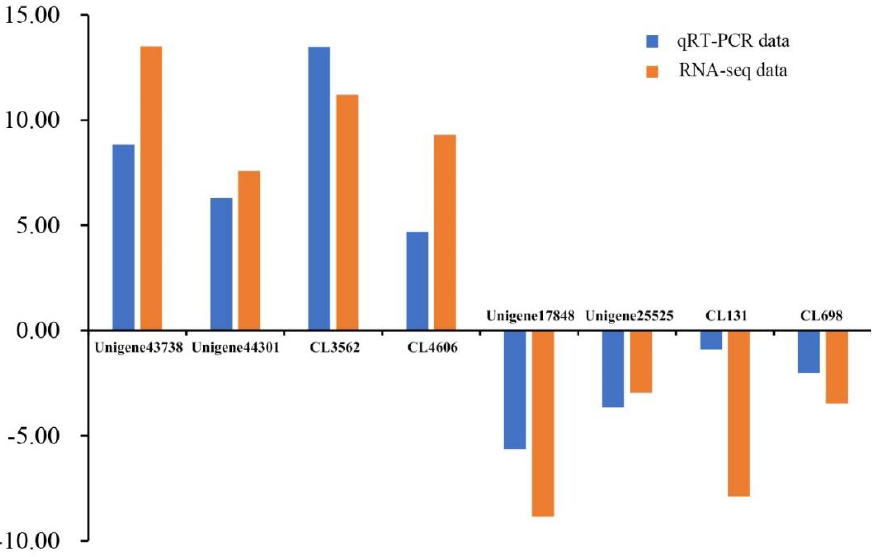
Figure 7. Expression levels of eight unigenes as determined by transcriptome analysis and